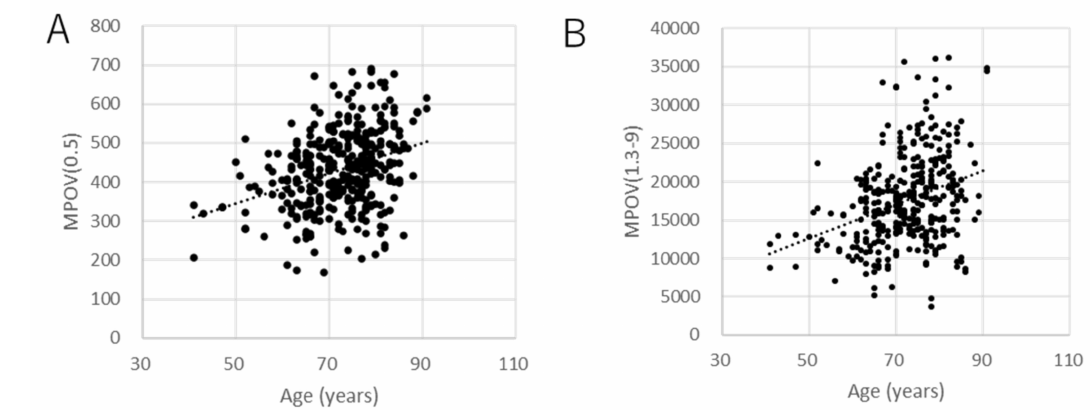
Figure 3. Scatter plots of MPOV against age. ( A ) MPOV(0.5) (coefficient = 3.47, p < 0.001, linear mixed model), ( B ) MPOV(1.3–9) (coefficient = 209.3, p < 0.001, mixed linear